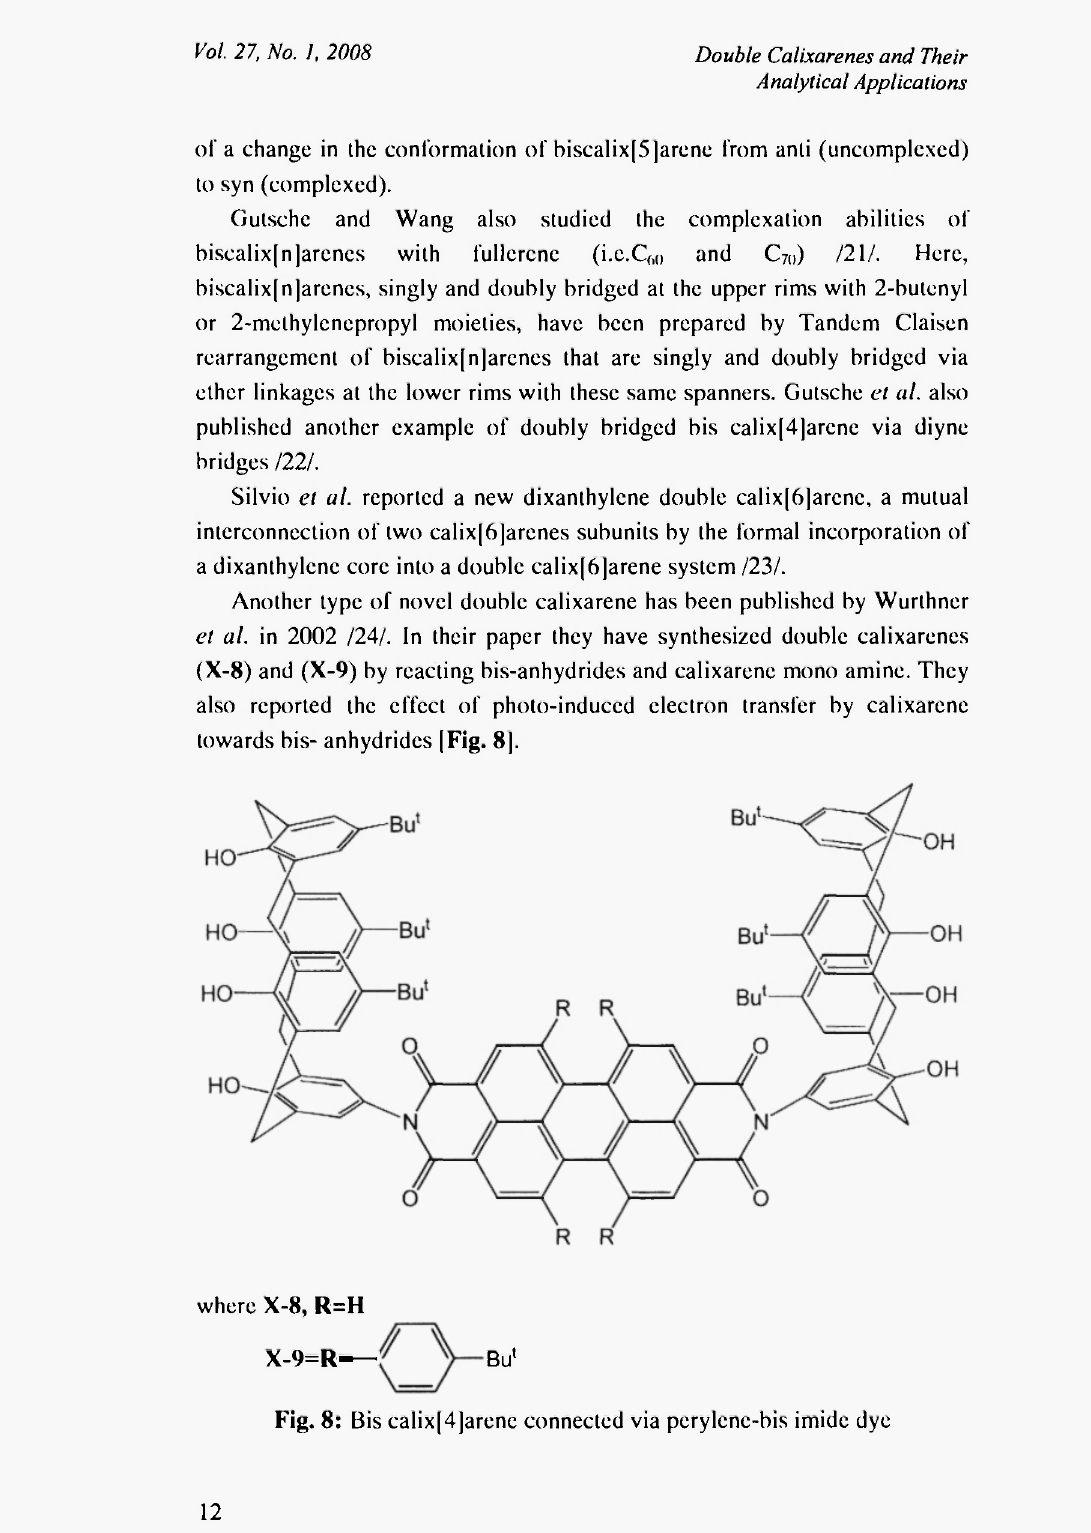
Fig. 8: Bis calix[4]arene connected via perylene-bis imide